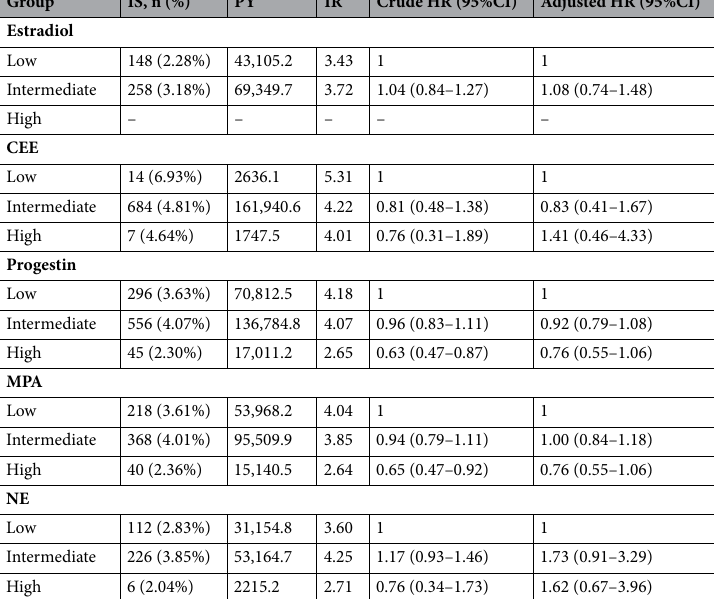
Table 3. Hazard ratios for ischemic stroke in different doses of estradiol and conjugated equine estrogen groups. Cox regression model was adjusted for age and comorbidities listed in Table 1. HR, hazard ratio; PY, person-year; CI, confidence interval; CEE, conjugated equine estrogen; MPA, medroxyprogesterone acetate; NE, norethindrone